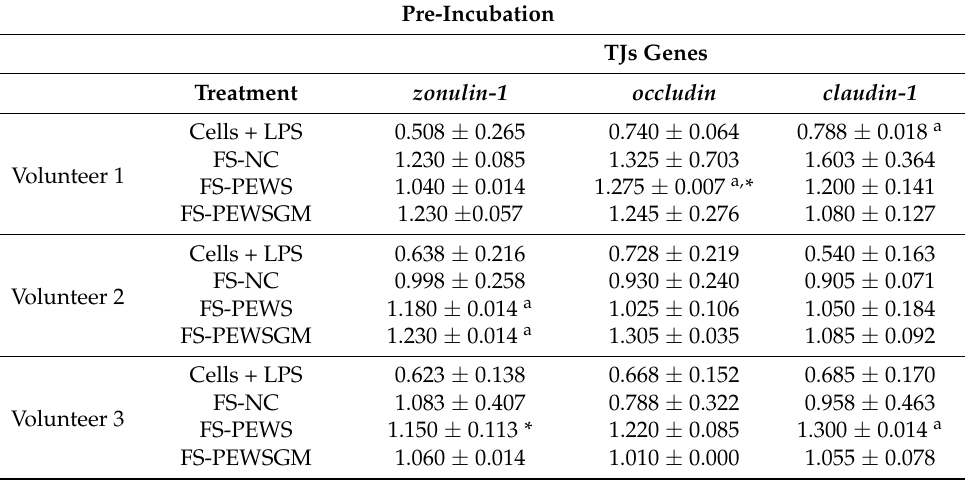
Figure 4. The effects of FSs from P. eryngii mushrooms (FS-PEWS and FS-PEWSGM) on claudin-1 expression levels in LPS-induced Caco-2 cells. Caco-2 cells were subjected to LPS and FS treatment under three different conditions: pre incubation (FS/LPS), co-incubation (FS + LPS) and post-incubation (LPS/FS). Untreated: Caco-2 cells without any effect; FS-NC: FS of the negative control (NC: sample without additional carbon source); Cells + LPS: Caco-2 cells subjected to LPS (100 ng/mL). Data are expressed as mRNA expression (normalized with b-actin ) relative to untreated cells as mean ± SD of two independent experiments. a statistically significant for FS-PEWS or FS-PEWSGM compared to untreated cells ( p < 0.05), + statistically significant for FS-PEWS or FS-PEWSGM compared to FS-NC ( p < 0.05), * statistically significant for FS-PEWS or FS-PEWSGM compared to Cells + LPS ( p < 0.05) (Wilcoxon matched-pairs signed rank test or paired samples t -test). Table 3. Expression levels of TJs genes under three conditions (i.e., pre-incubation, co-incubation and post-incubation) per